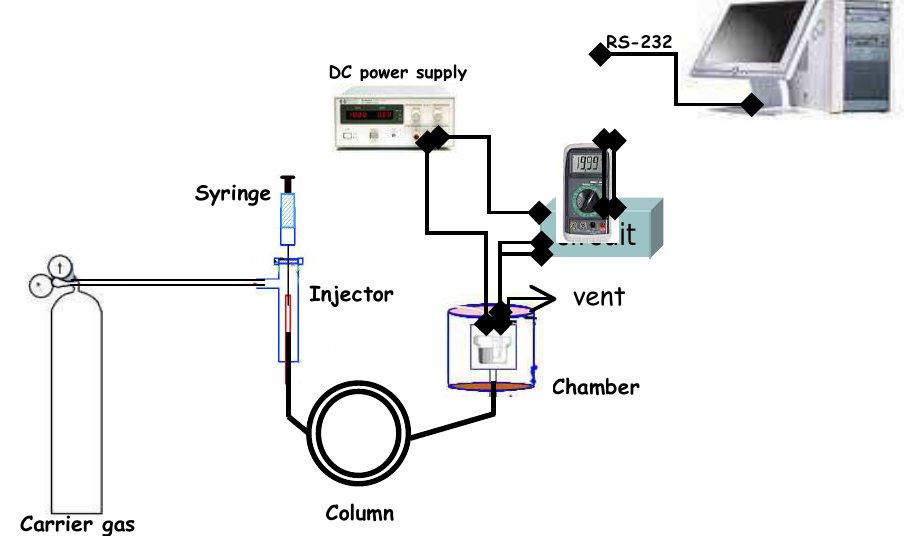
Figure 1. Schematic diagram for the detection device of ethanol and